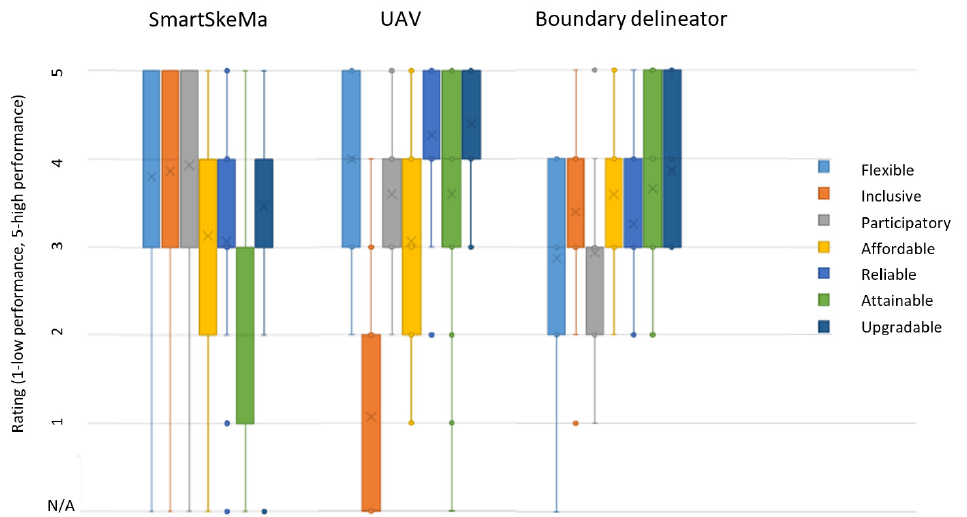
Figure 9. Assessment of the tools against the FFP elements.